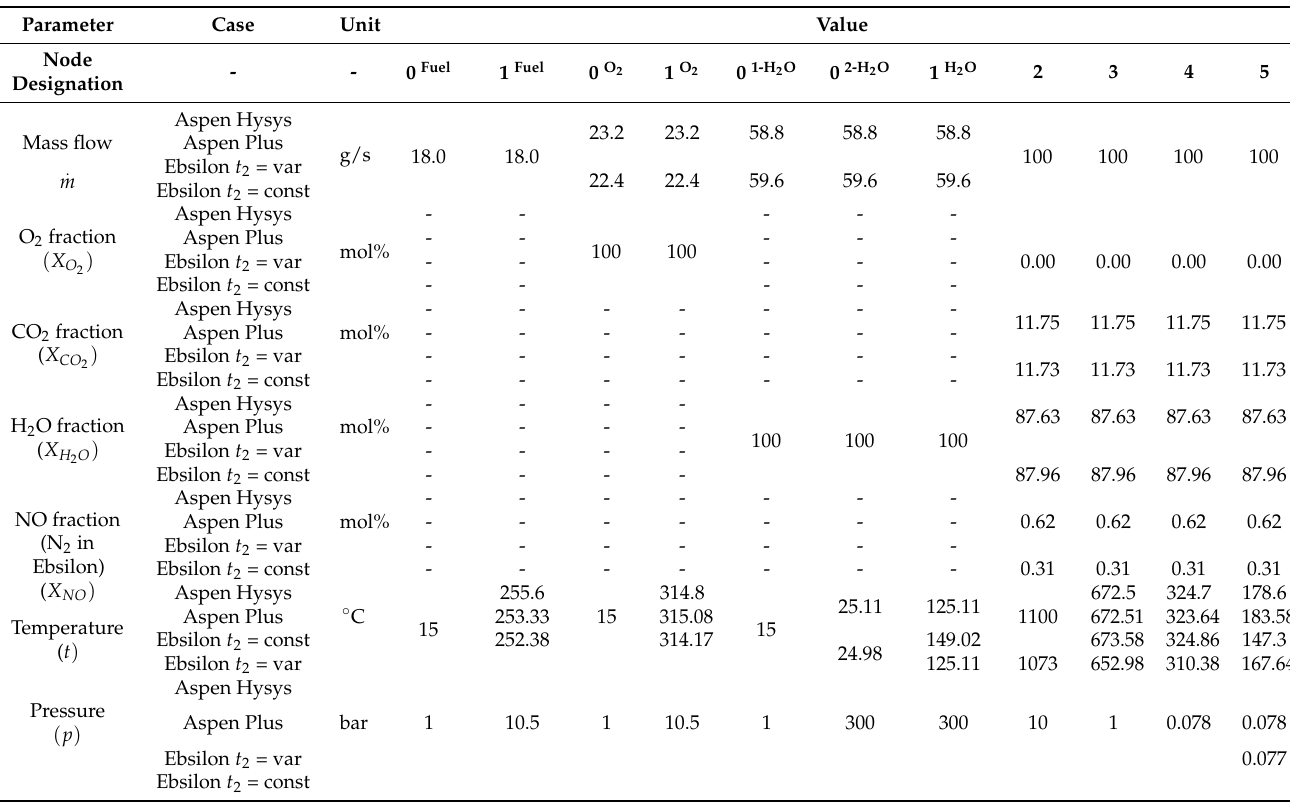
Table 7. Cycle nodal points on basis of syngas—mixture of gases as a fuel.